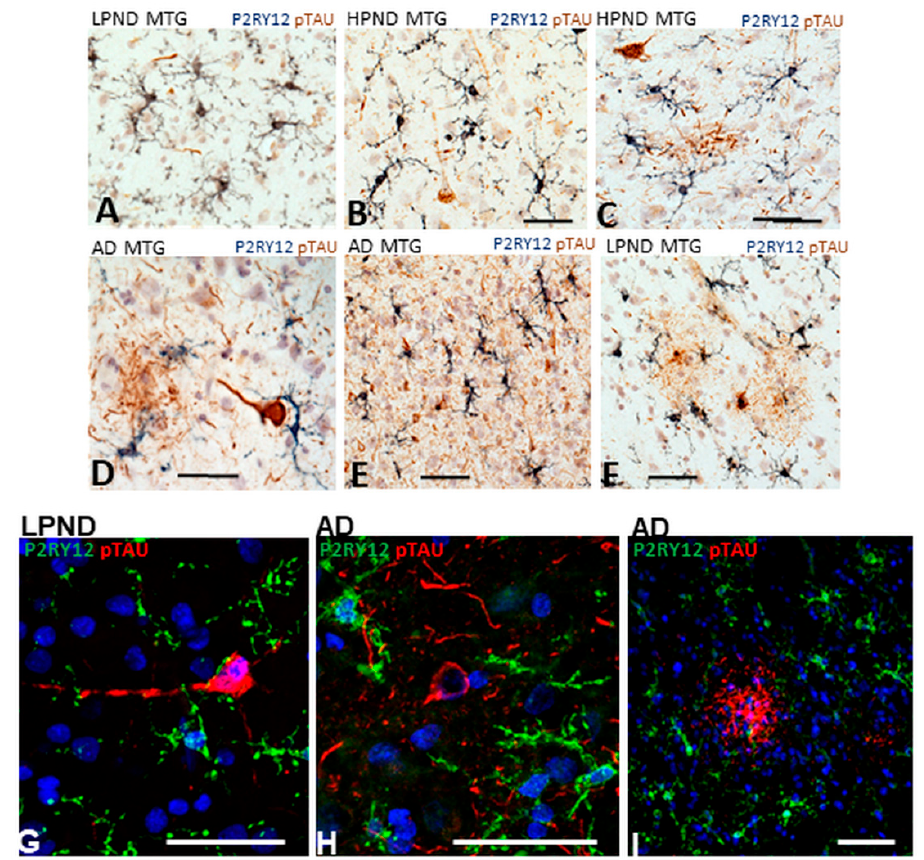
Figure 10. Features of P2RY12-positive microglia interacting with phosphorylated tau-containing